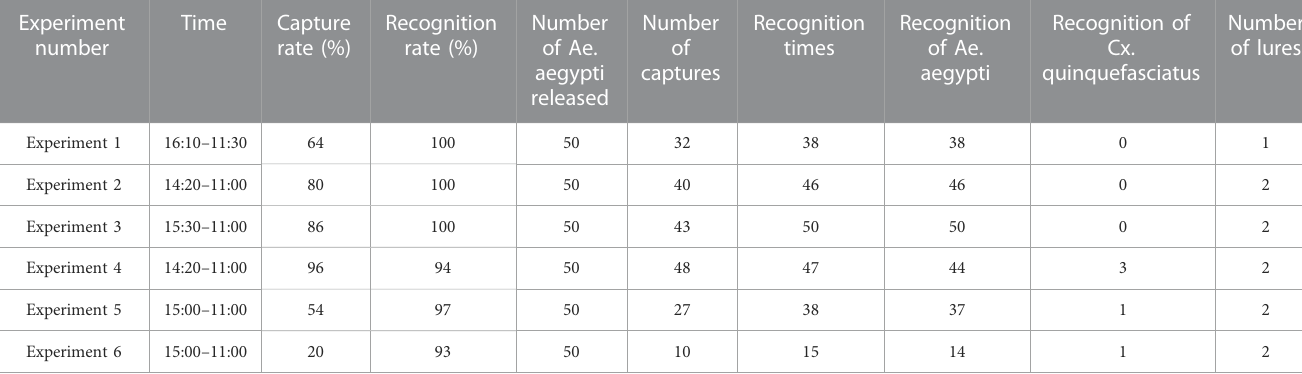
TABLE 4 Experimental results of the BG trap integrated with the developed mosquito trap core device in an insect cage. The test setup is shown in Supplementary Figure S7. Fifty Ae. aegypti mosquitoes were placed into the insect cage, which was 60 cm × 60 cm x 120 cm, for capture and identi fi cation by the mosquito trap. The test environment temperature was maintained at 27 ° C ± 1 ° C by an air conditioning system. Each test was performed independently and repeated 6 times. Experiment